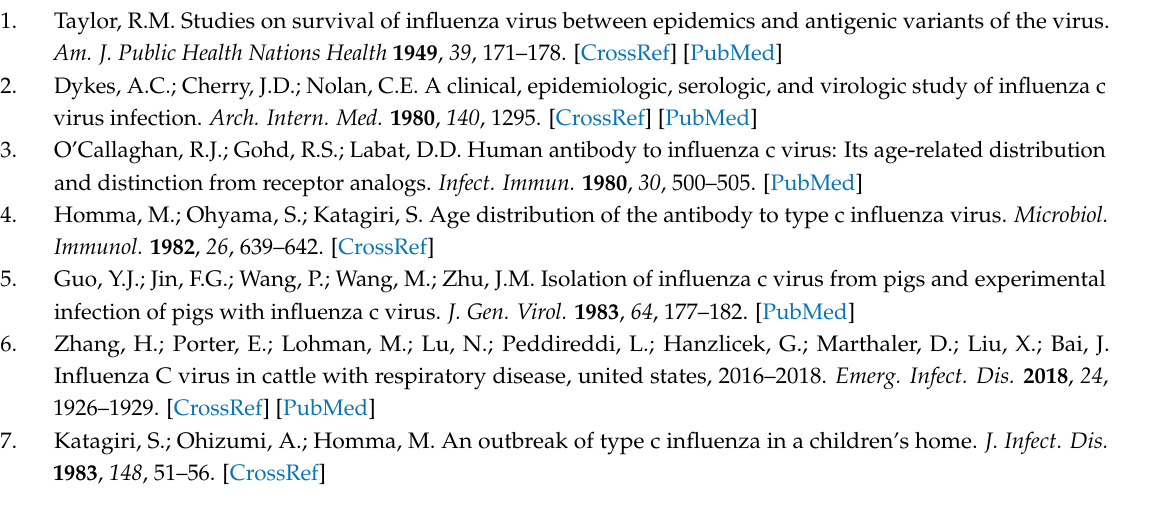
Table S1: Explanation of the variation of ICV HE gene by axis, Table S2: The relative synonymous codon usage (RSCU) patterns of ICV M gene and its hosts, Table S3: The site-by-site selection analysis results of the rest of amino acids. Data S1: Sequence data of influenza C viruses HE gene and M gene used in this study. Data S3: The nucleotide compositions analyses of HE and M gene used in this